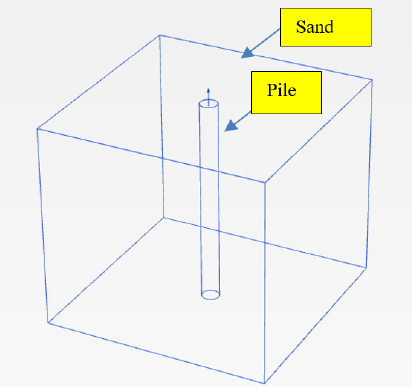
Figure 9. Mesh discretisation.